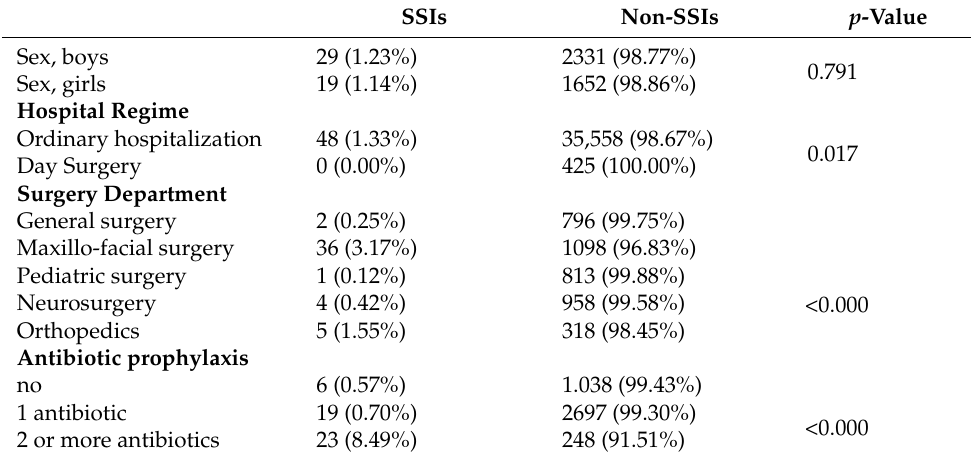
Table 1. Study population